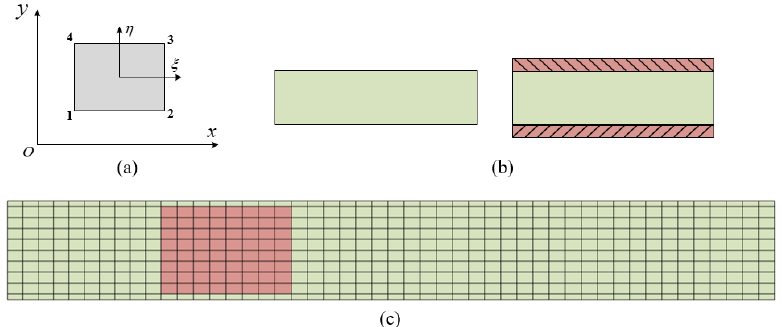
Figure 2. Finite element model of the piezo-actuated plate: ( a ) Quadrilateral plate element; ( b ) cross- sections of the elements; ( c ) meshes of the structure.